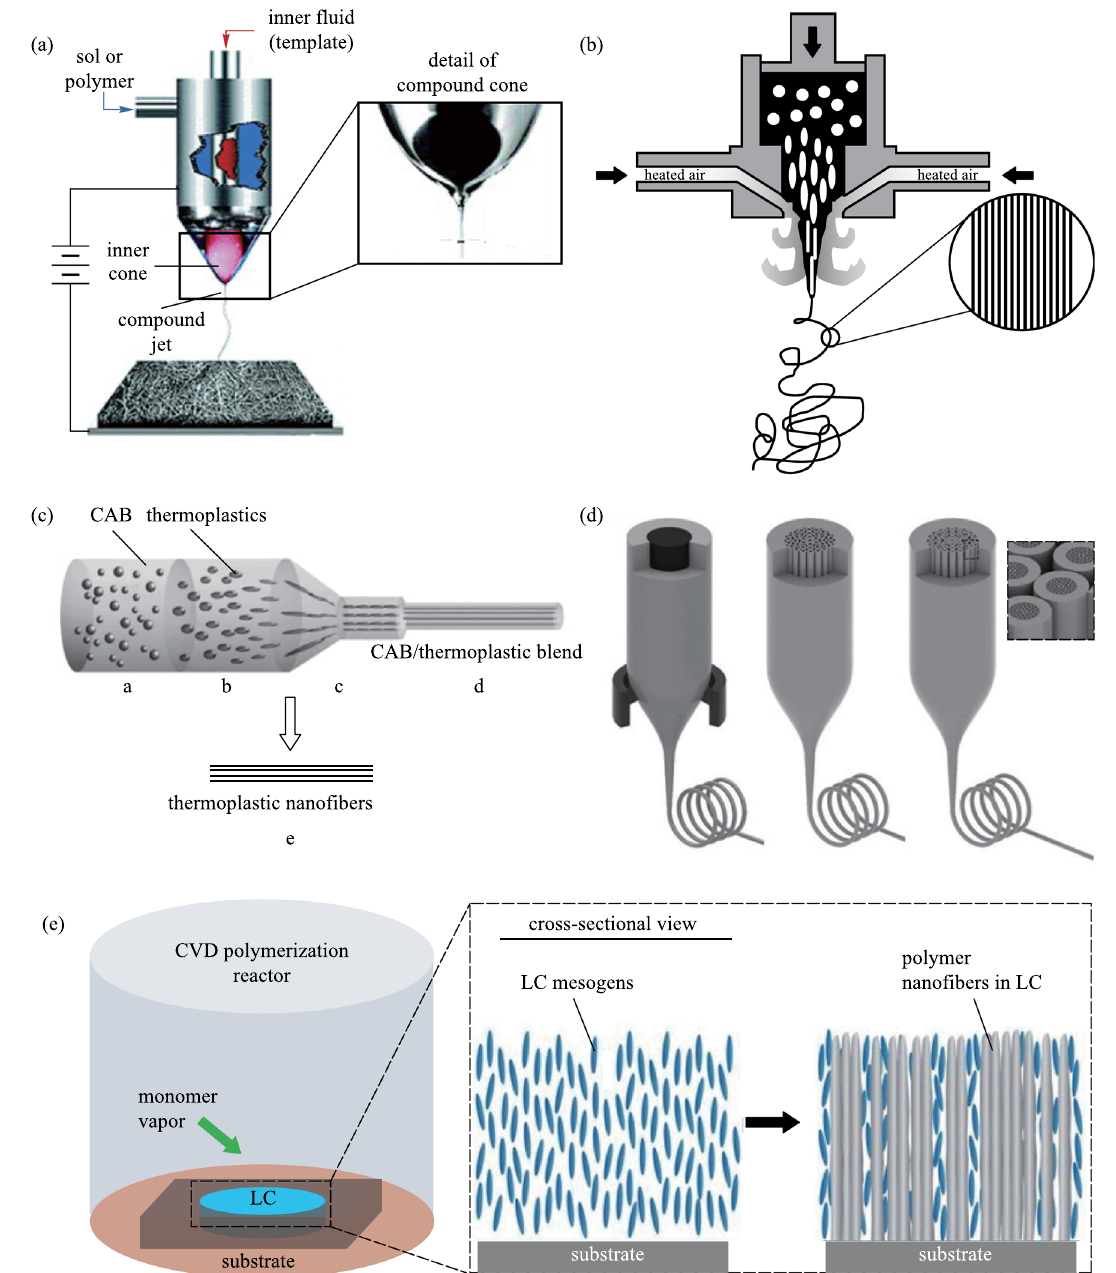
Fig. 2 Schematic diagram of common nanofiber preparation methods. a Electrospinning [55]. b Melt blowing [27]. c Sea island [49]. d Thermal drawing [25]. e Chemical synthesis